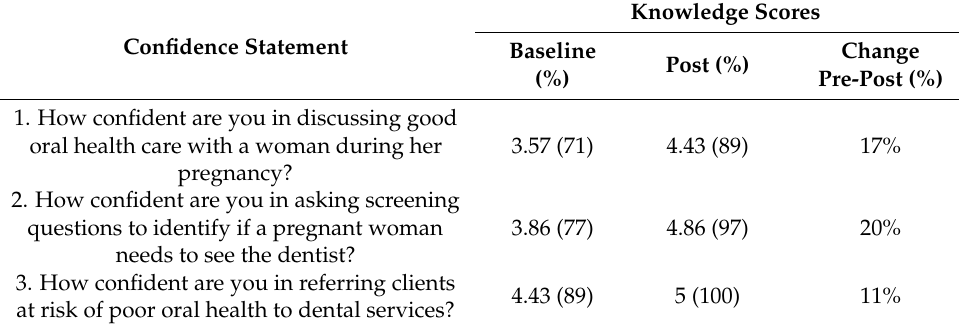
Table 4. Change in oral health confidence pre-post